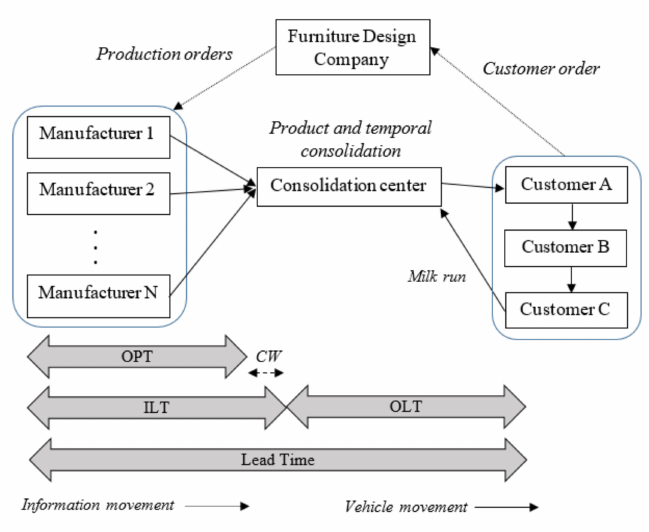
Figure 1. Supply chain